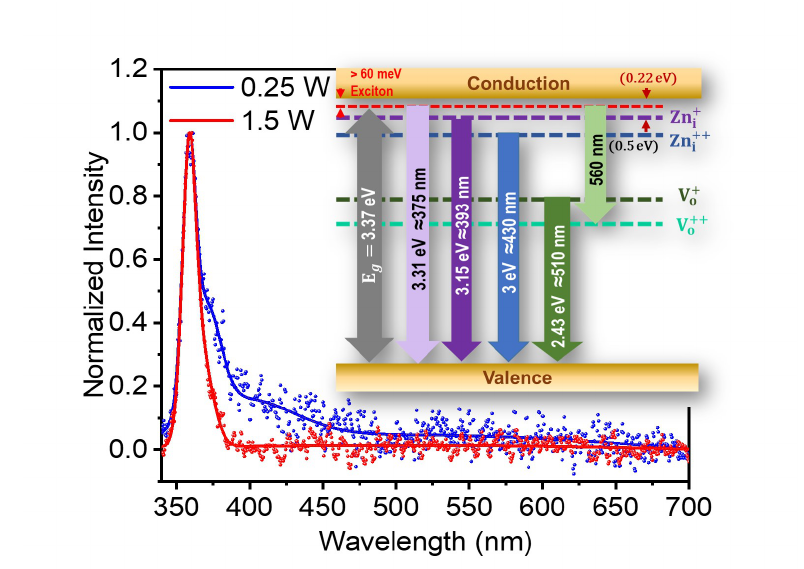
Figure 5. Cathodoluminescence spectra of Mg-doped ZnO nanoparticles. The specimens were prepared at two different ablation powers 0.25 W (blue) and 1.5 W (red) using a beam of 500 fs pulses in the fs-PLAL process. Inset The energy levels relevant for the discussion on the luminescent emission from ZnO systems are depicted including the valence and conduction bands, excitonic states, Zn-interstitials and oxygen